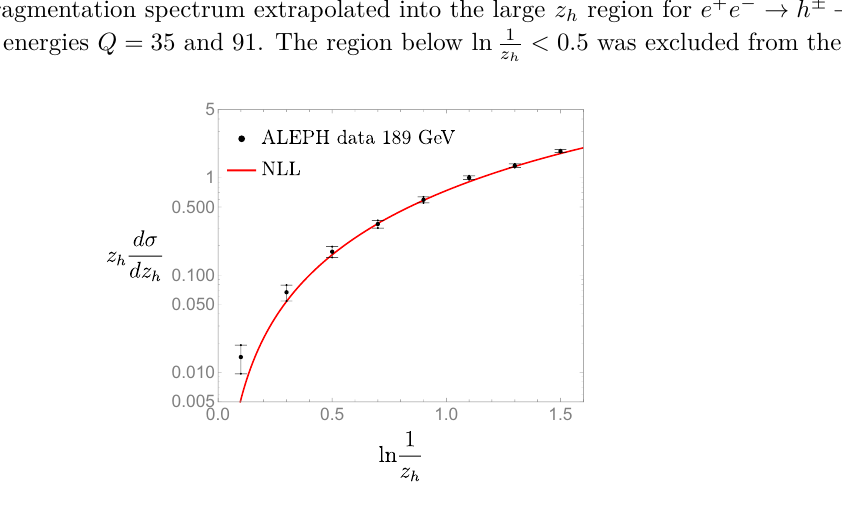
Figure 8 . The fragmentation spectrum extrapolated into the large z h region for e + e − → h ± + X at center of mass energies Q = 189 . The region below ln 1